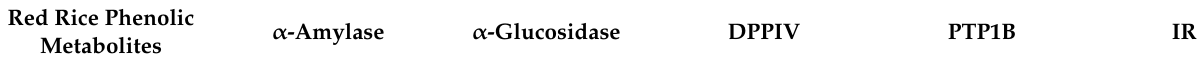
Table 5. Summary of the molecular interactions between the red rice phenolic metabolites (with low binding energies) and the active sites of the target proteins involved in glucose